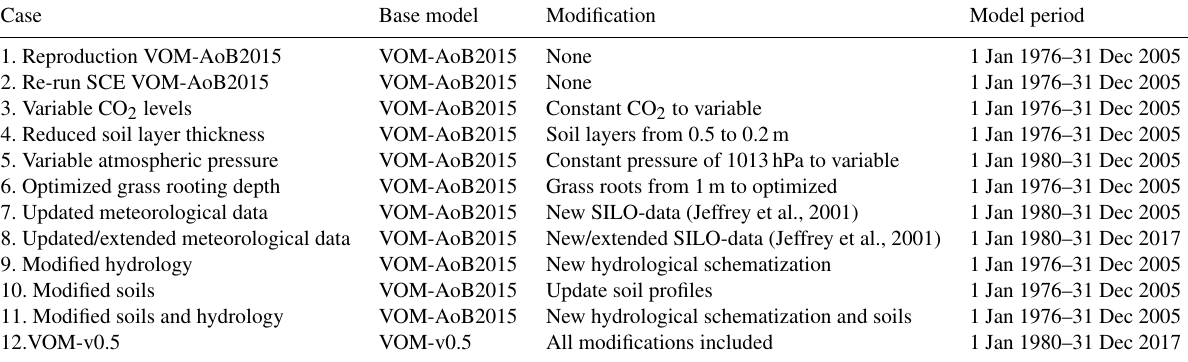
Table 4. Modifications to